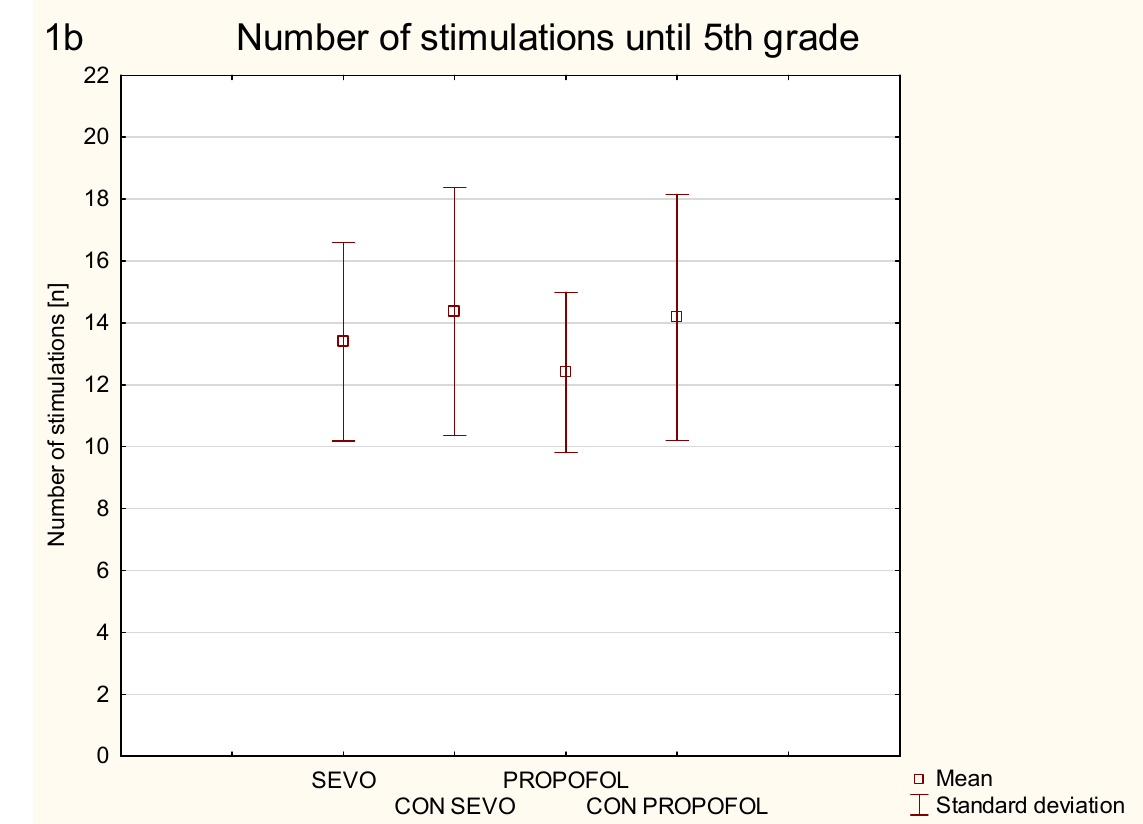
Figure 1. Presents the number of stimulations needed to achieve 4th grade seizures ( 1a ) and 5th grade seizures ( 1b ) according to the Racine scale in corneal kindling model: SEVO—mean number of stimulations in the group of rats exposed to sevoflurane on 6th postnatal day at the concentration of 2.5–3.5 vol % for 6 h; PROPOFOL—mean number of stimulations in the group of rats exposed to propofol (cumulative dose 90 mg/kg during 4.5 h); CON SEVO—mean number of stimulations in the control group for sevoflurane; CON PROPOFOL—mean number of stimulations in the control group for propofol. Whiskers represent standard deviation. Mann-Whitney test was used. p < 0.05 was assumed as statistically significant.